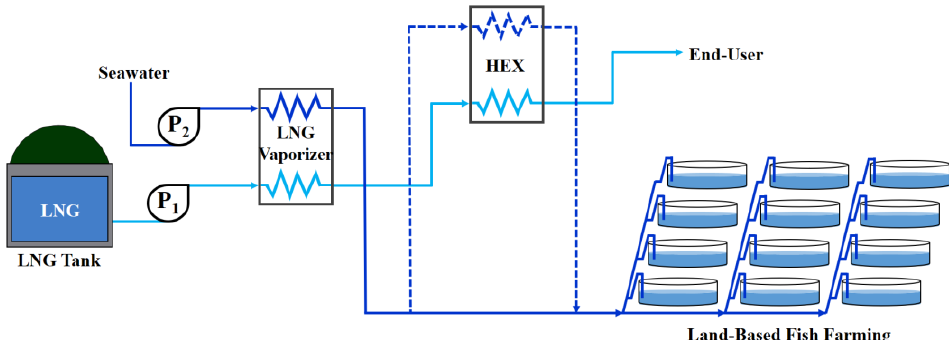
Figure 4. Flow diagram showing the concept of cold seawater supply for land-based cold water fish aquaculture utilizing LNG cold energy.